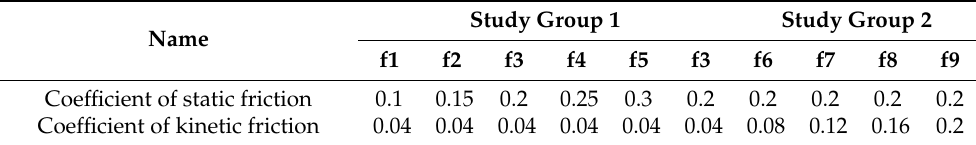
Table 4. Locking rod and locking claw friction coefficient